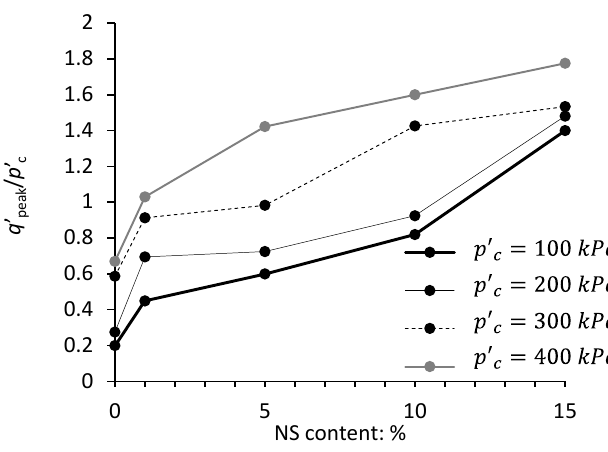
Figure 9. Variation of normalized peak shear strength with nano-silica content.